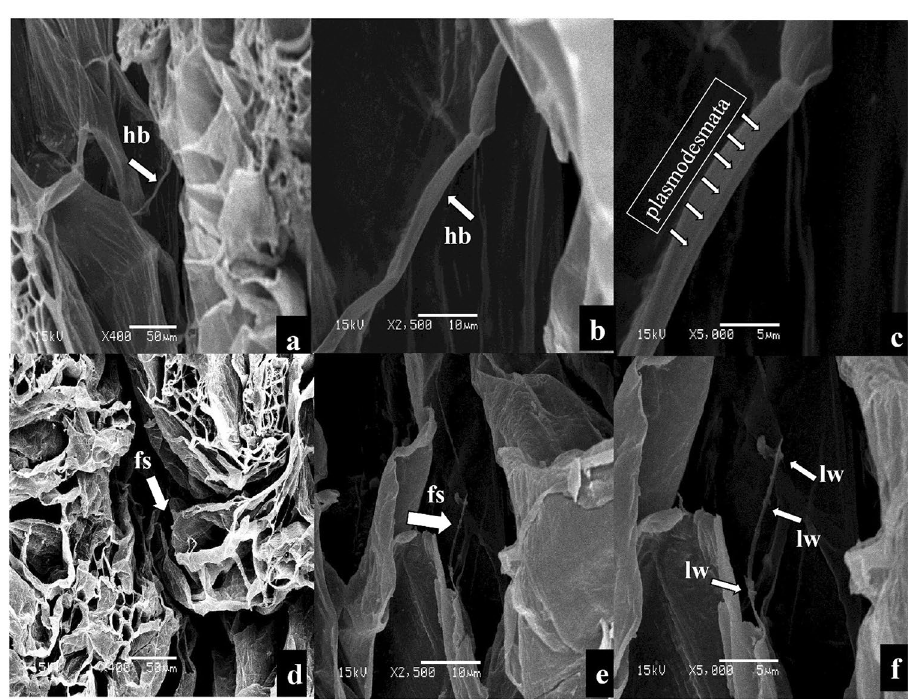
Figure 6. SEM images of interconnections in union grafting under R7:B3 light ( a – c ) and B light ( d – f ) grafting combinations, after 5 DAG. Magnification shows the plasmodesmata under R7:B3 ( c ), the structural features of filamentous interconnections, and the entity of lipid/waxy materials on their surface under BED light ( f ). fs— filamentous structures; hb—horizontal bridge;